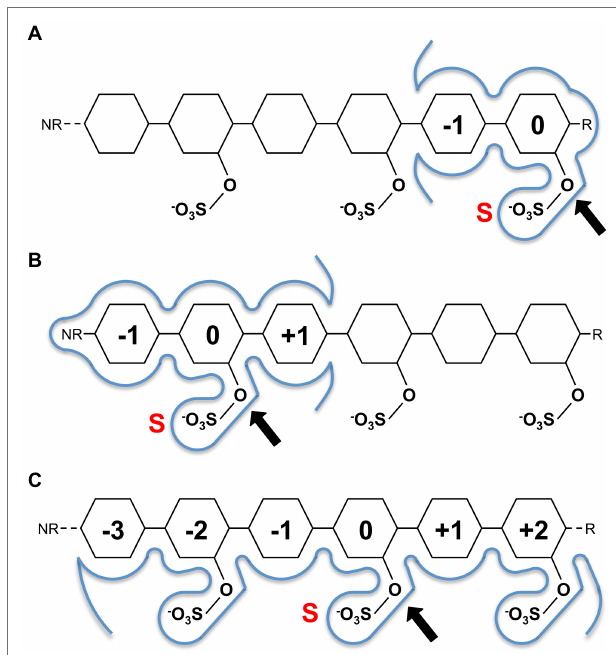
FIGURE 2 | Sugar binding subsite nomenclature carbohydrate-active sulfatases as adapted from Hettle et al. (2018). Examples shown for hypothetical reducing end exo -acting sulfatase (A) , non-reducing end exo -sulfatase (B) and endo -acting sulfatase (C) . The ‘S’ subsite is indicated by a red S with a black arrow identifying the targeted sulphate ester for hydrolysis. The 0-subsite accommodates the sugar monosaccharide with the targeted sulphate ester, additional subsites are numbered negative towards the non- reducing end (NR) and positive towards the reducing end (R). Sugar residues are represented as